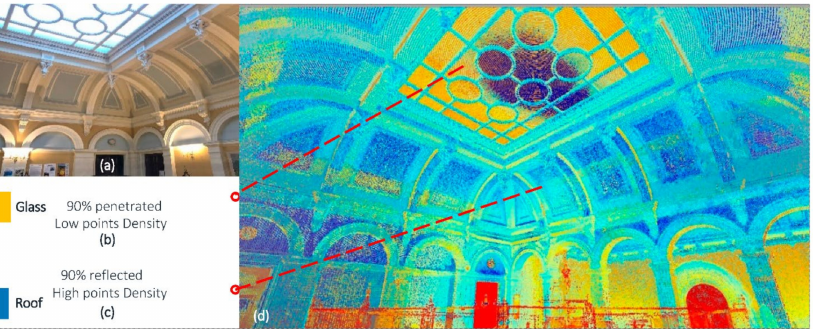
Figure 13. ( a ) Original photograph; ( b ) main hall glass roof; ( c ) main hall roof structure; ( d ) penetra- bility